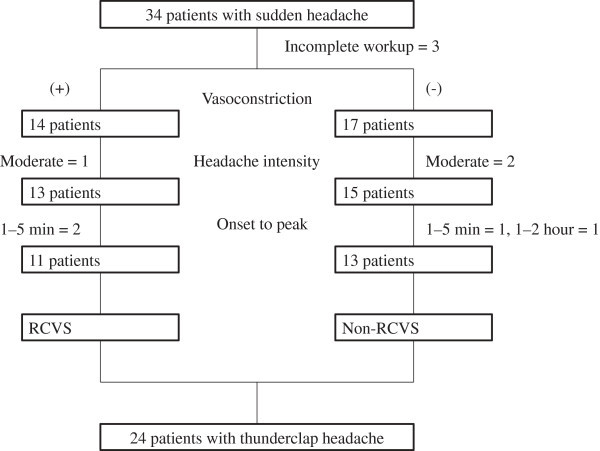
Screening scheme for patients with sudden headache. Moderate headache intensity refers to 4-6 on a 0-10 numerical rating scale. RCVS: reversible cerebral vasoconstriction syndrome.